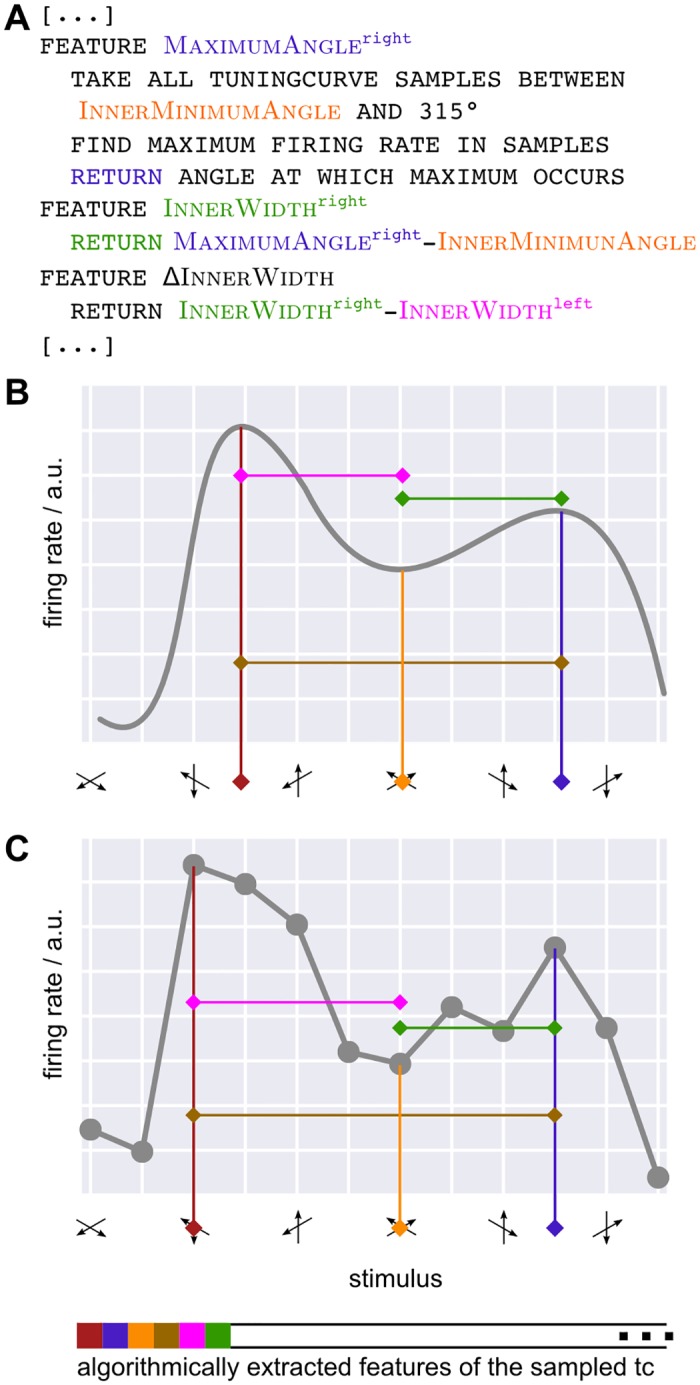
Alternative to fitting: algorithmic features.A) We describe all tuning curve properties of interest by algorithmically extracted features, as opposed to model parameters. The panel gives pseudocode for three selected features, illustrated also in panels B,C in corresponding colors. B) Feature extraction algorithms take as input only the sampled fitted tuning curve. Features are thus defined independent of a model function, allowing for their comparison between models. Furthermore, all aspects of tuning curves can be described by suitably chosen features such as Maximumleft (dark red), InnerMinimum (orange), Maximumright (blue), (occuring at positions MaximumAngleleft, InnerMinimumAngle and MaximumAngleright, respectively), InnerWidthleft (pink), InnerWidthright (green). C) Due to their algorithmic nature feature extraction rules can equally well be applied directly to the coarse measured trial-averaged tuning curve. Thereby, tuning curve properties can be described and analyzed without referring to the fit.